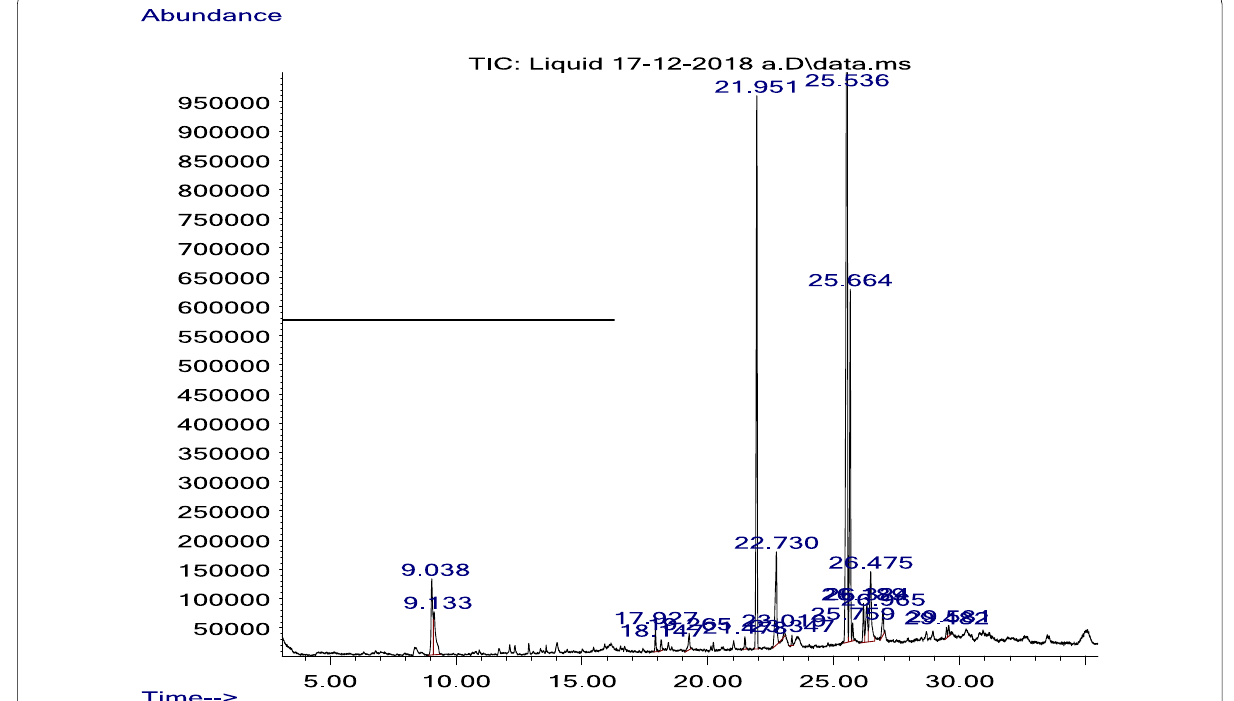
Fig. 3 Chromatogram of the chemical compounds present in cowpea pod extract